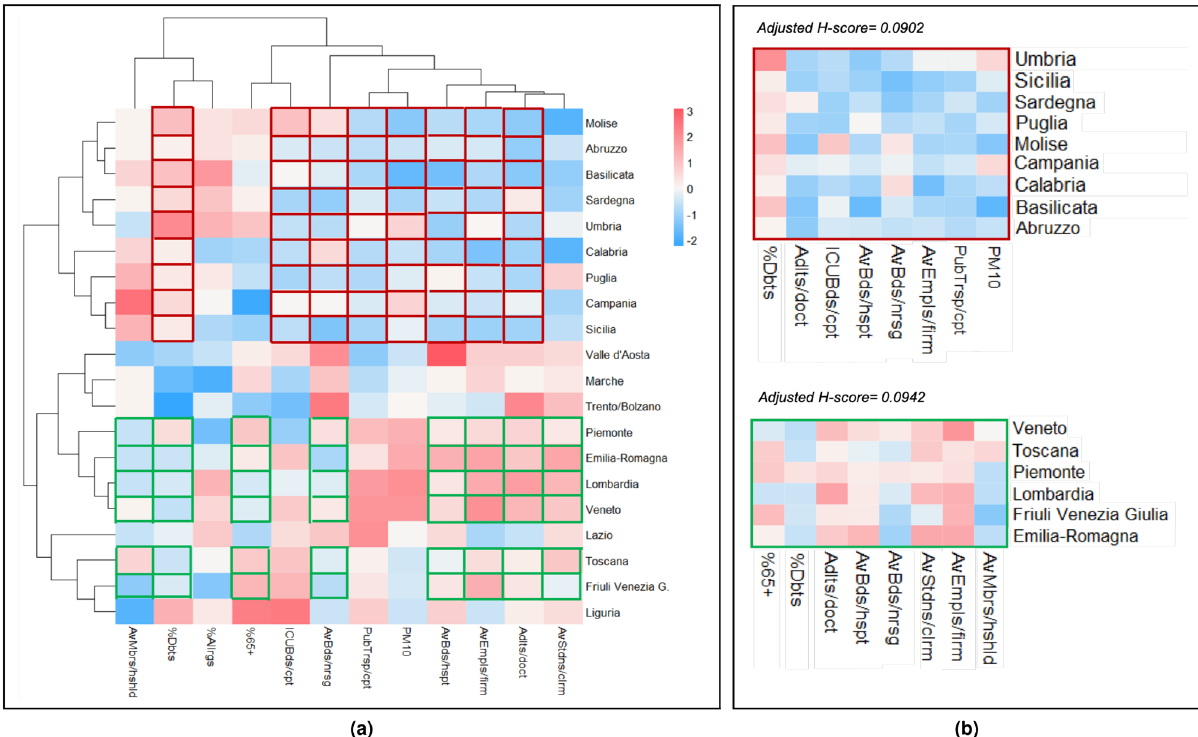
Figure 5. Interdependencies among scalar covariates and regions. ( a ) Heatmap of the 20 (regions) × 12 (covariates) data matrix, with dendrograms from separate hierarchical clustering (correlation distance, complete linkage) of the regions (left) and the covariates (top). Color coding within cells represents values of the standardized covariates (centered and scaled to mean 0 and standard deviation 1). Color coding of some cell borders identifies the biclusters in ( b ). The dendrograms capture a distinct interdependence structure. For instance, there are marked similarities among Lombardia, Veneto, Emilia Romagna and Piemonte, as well as among some groups of southern regions (Sicilia, Campania, Puglia and Calabria; Basilicata, Abruzzo and Molise). There are also marked associations among groups of covariates. The contagion hubs proxies for hospitals, schools and work places, and number of adults per family doctor, vary closely together. So do the contagion hub proxy for public transport and pollution levels; the percentages of individuals affected by diabetes and allergies; and ICU beds and the percentage of individuals over 65. ( b ) Restricted heat-maps further illustrating interdependencies through two biclusters of regions and covariates. Color-coding within cells corresponds to that in ( a ), and each bicluster is identified by a border color and its adjusted H-score (an inverse and southern regions with “flat(tened)” epidemics (Group 2). The second bicluster (adjusted H-score = 0.0942